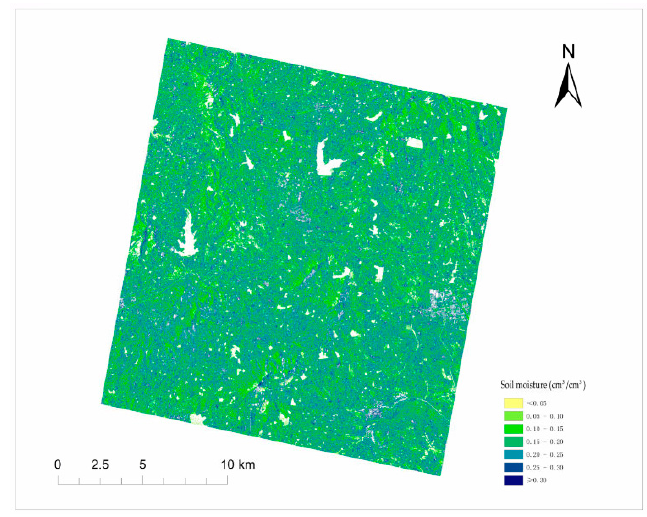
Figure 12. Map of retrieved soil moisture content based on the optimal solution method under strategy 2.